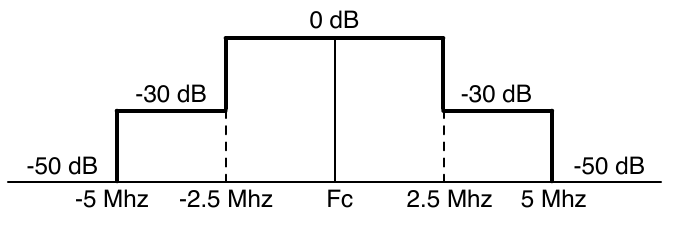
Figure 2. Transmit spectrum